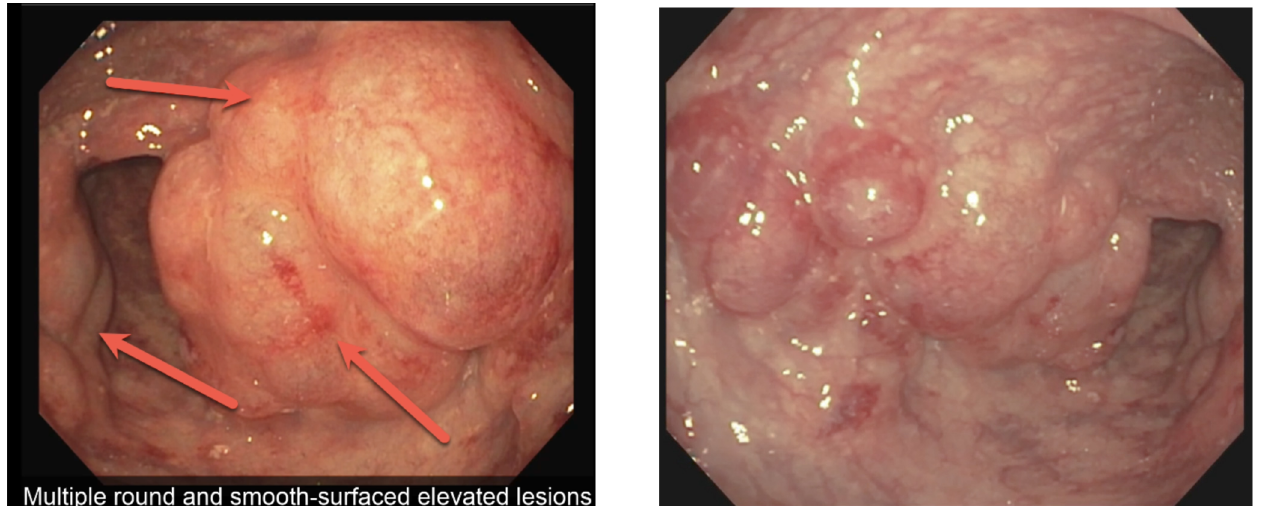
Figure 1. A 45-year-old female patient with a medical history of constipation and recurrent diverticulitis presented herself for an elective colonoscopy eight weeks after her last episode. In the descending colon the red arrows point to multiple rounded and elevated, softened smooth-surfaced, mucosal lesions with foci of enanthem were found without loss of mucosal contiguity. These lesions were homogeneously distributed over the entire circumference of this intestinal segment. PCI is classified into primary (idiopathic) and secondary forms, with 15% and 85% of presentations, respectively [1,2].